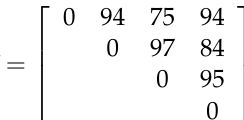
Figure 11. ( a , b ) Photographs of the experimental setup to demonstare the GRF measumement during walking. ( c ) Camera image during the experiment. The time interval is 0.1 ms. (cI) Camera image before the sole contacts the FP. (cII–VIII) Camera image while FP is in contact with the sole. (c-IX) Camera image after the sole contacts the FP.